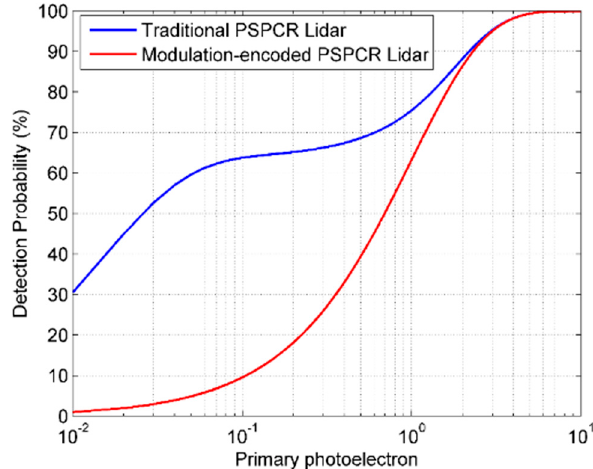
Figure 5. The detection probability of the traditional PSPCR Lidar and modulation-encoded PSPCR Lidar at different primary photoelectron number.